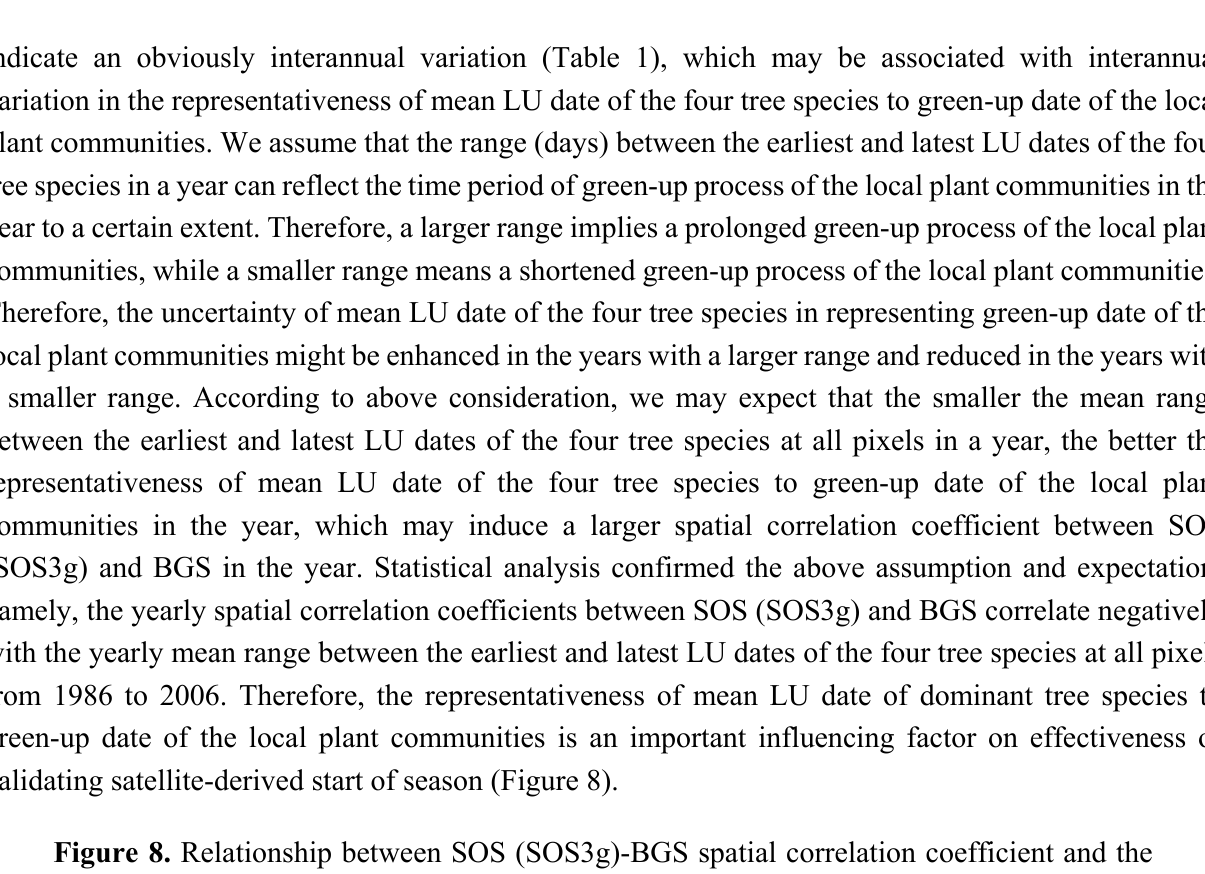
Figure 8. Relationship between SOS (SOS3g)-BGS spatial correlation coefficient and the mean range of leaf unfolding dates of the four tree species at all pixels from 1986 to